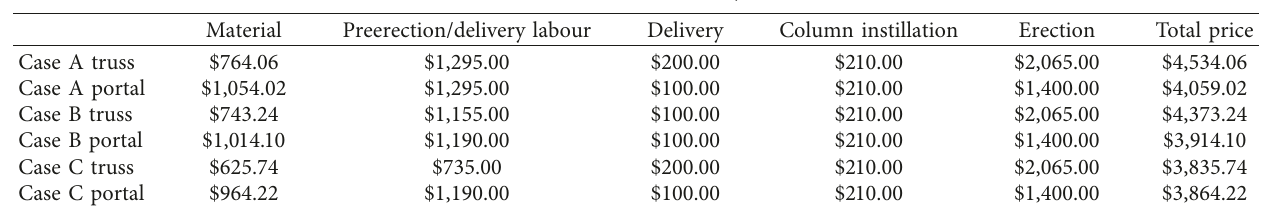
Table 9: Cost summary.